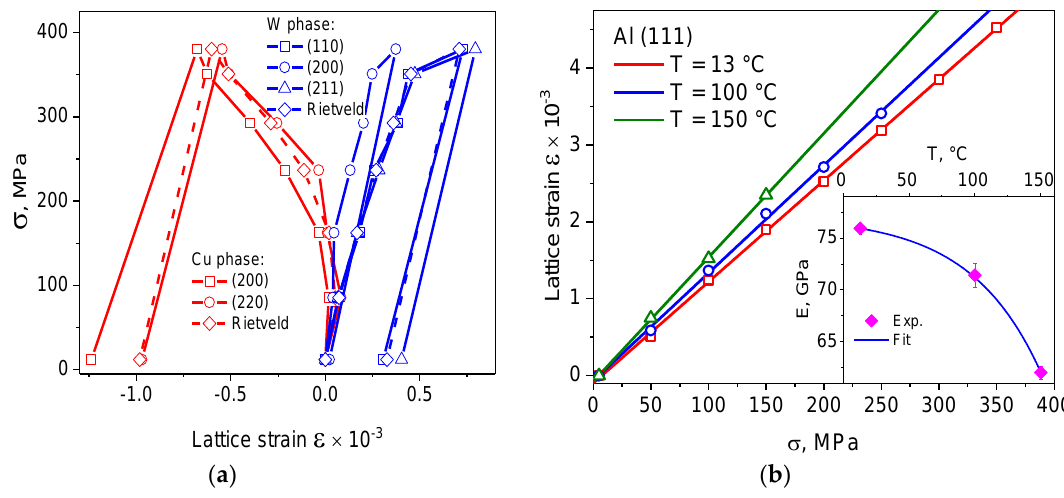
Figure 19. ( a ) Transverse lattice strain for different planes ( hkl ) of copper and tungsten phases in the W/Cu composite vs. external load. ( b ) Lattice strain for the (111) plane in the aluminium alloy vs. applied load measured at different temperatures: 13, 100, and 150 °С. Inset: temperature dependence of the elasticity modulus for the aluminium alloy: symbols designate experimental values, with the solid line corresponding to the least square fit E = E 0 − B∙T∙ exp(− T 0 / T ), adapted from [19], with permission from © 2018 Springer.